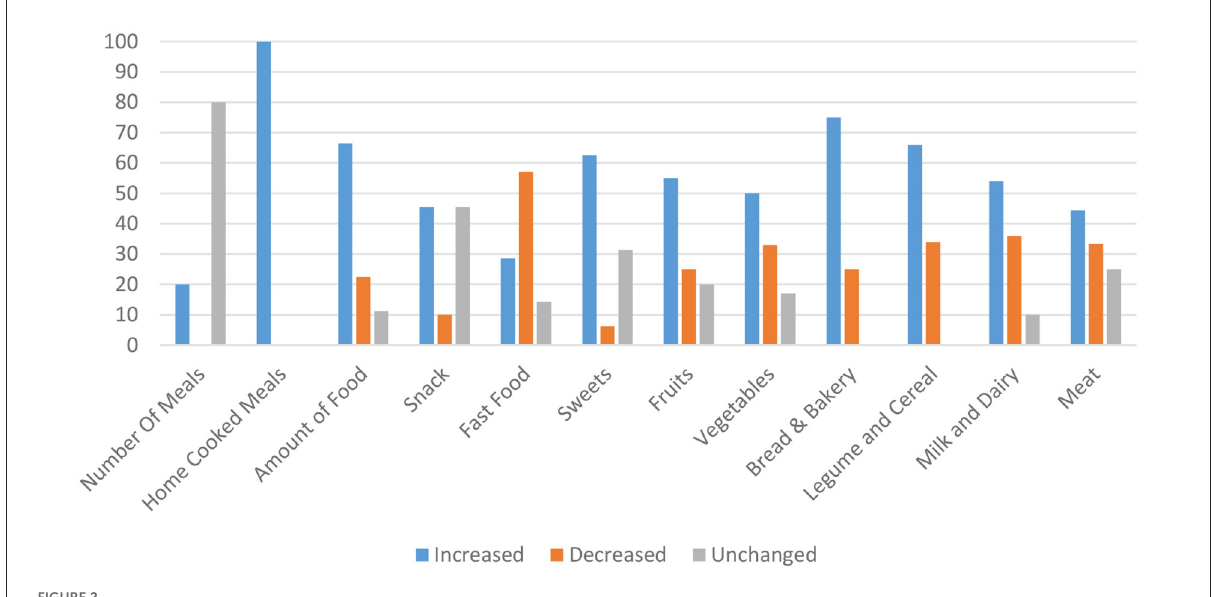
FIGURE2 Summary of eating habits changes according to percentage of